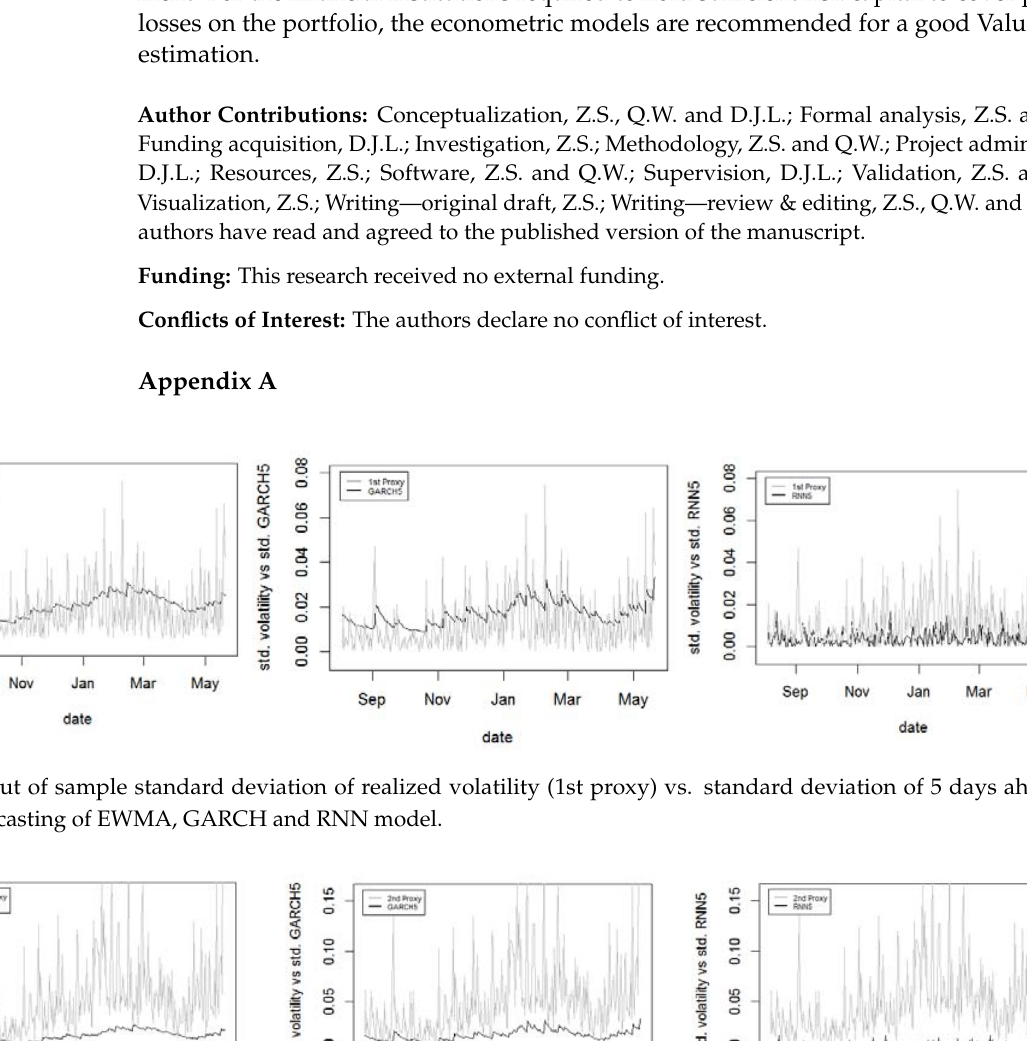
Figure 3 . Out of sample standard deviation of realized volatility (1st proxy) vs standard deviation of 10 days ahead volatility forecasting of EWMA, GARCH and RNN model